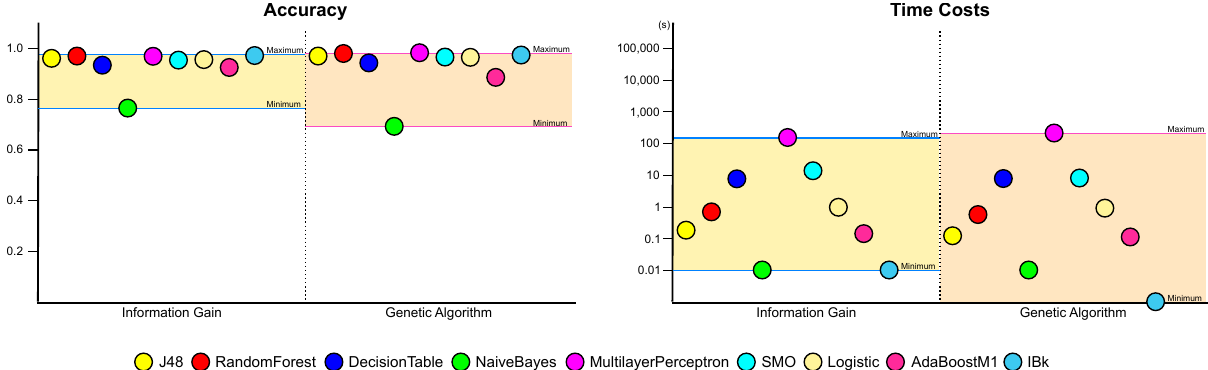
Figure 9. A comparison of machine learning performances between non-selection and genetic algorithm-based feature se- lection.